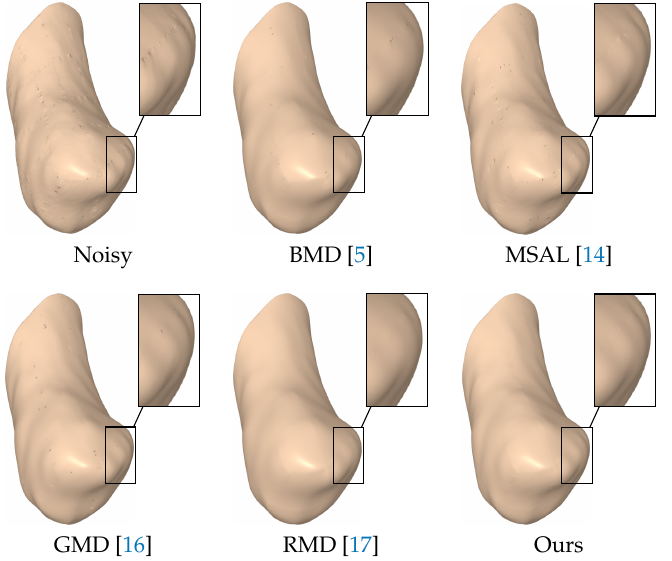
Figure 6. Surface denoising results of the noisy right metacarpal model corrupted by Gaussian noise with σ = 0.5. The magnified views of denoised models show that our method outperformed the baselines in preserving the surface features.